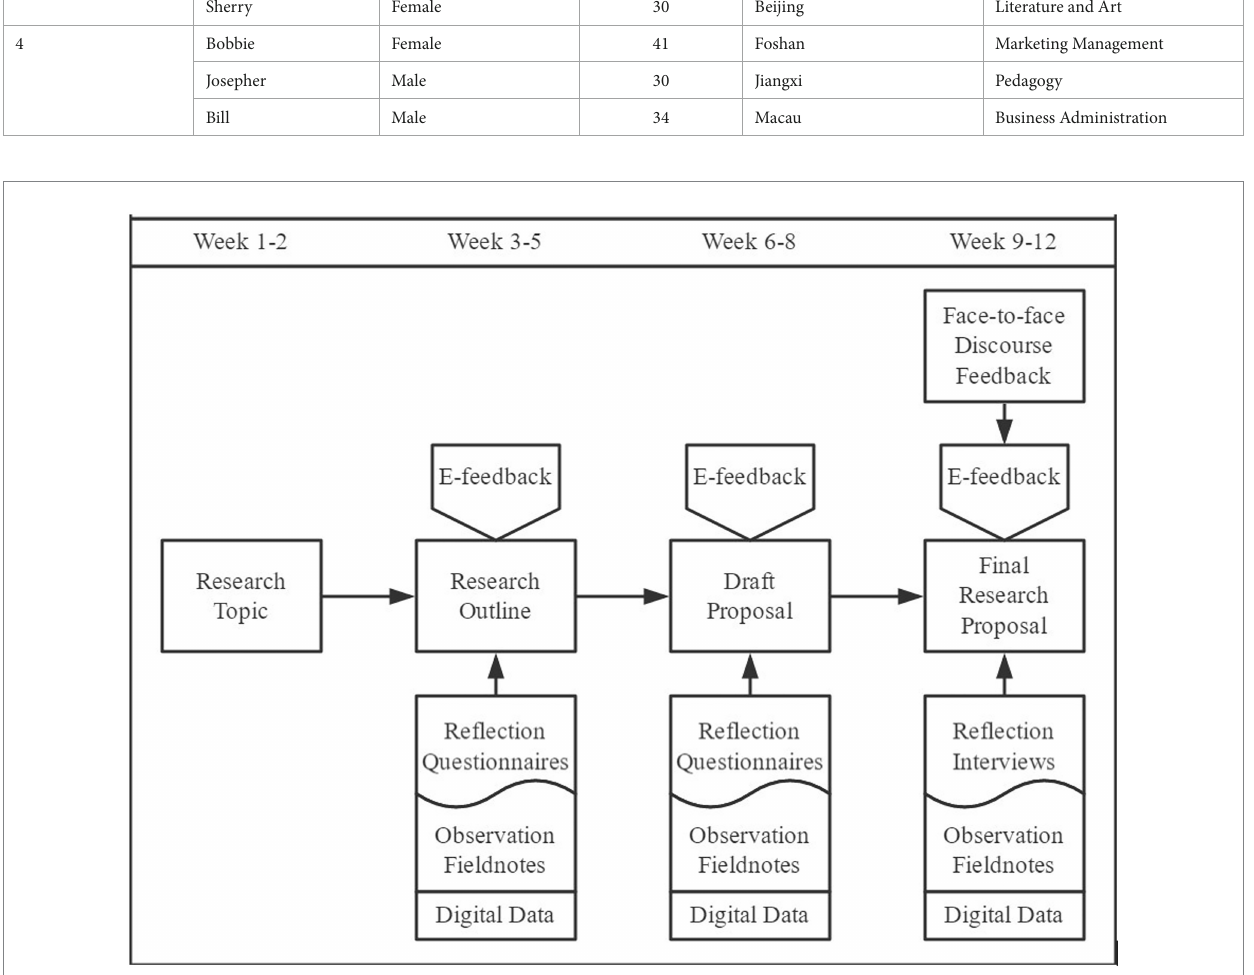
FIGURE 1 Course procedure and data